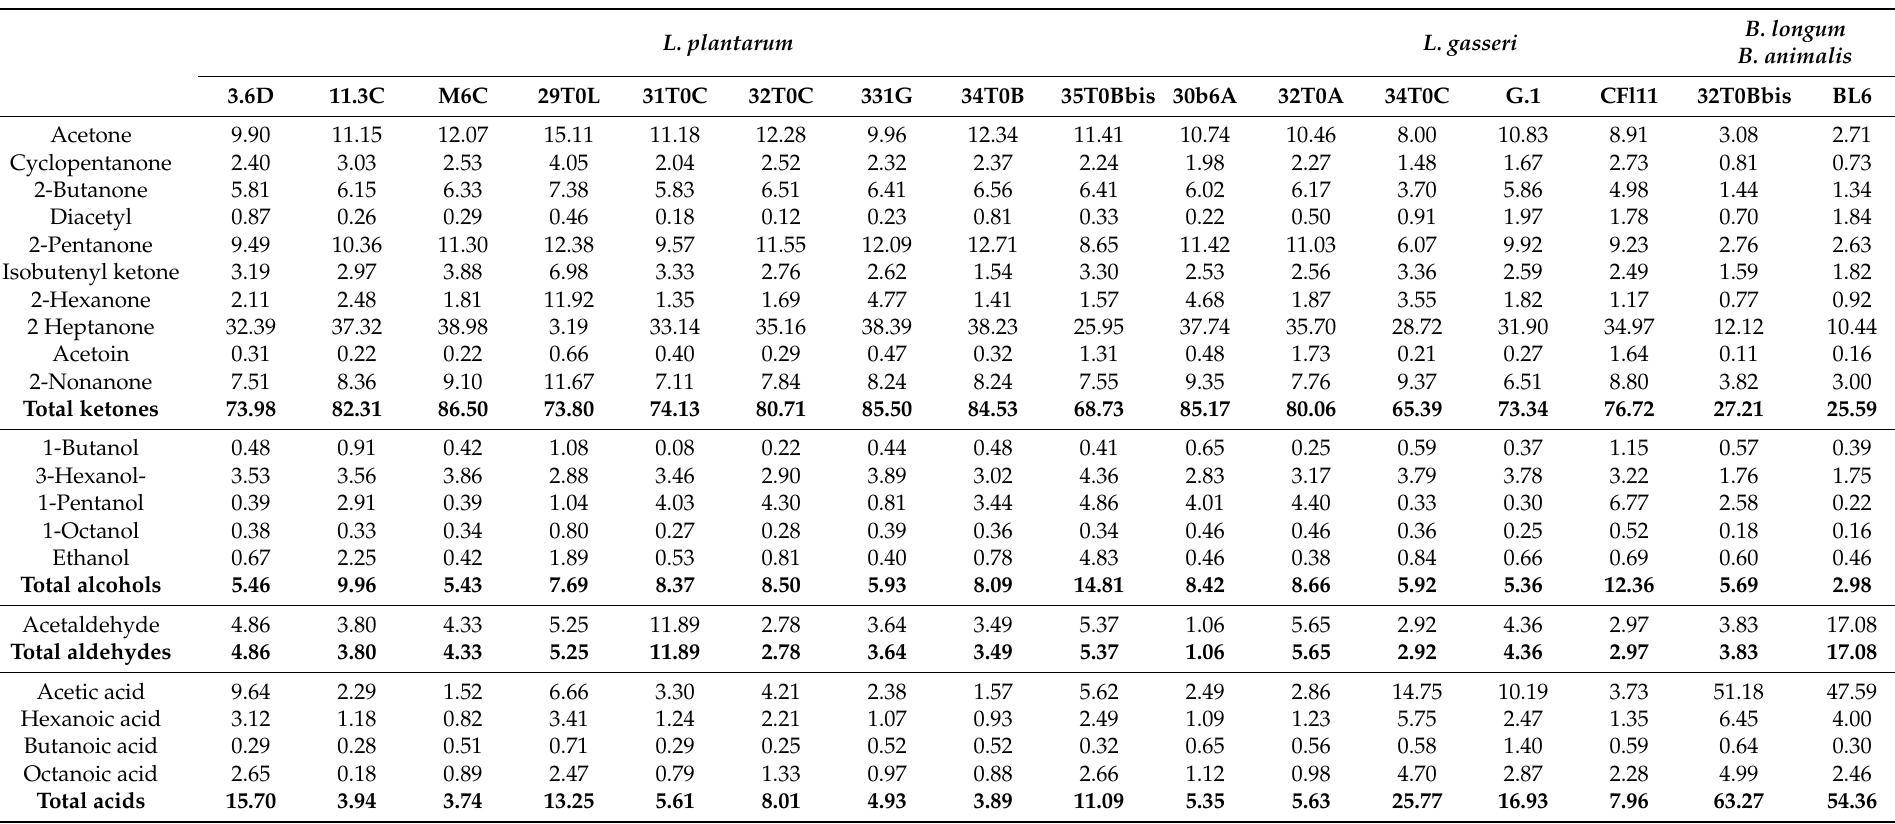
Table 9. Volatile compounds (reported as relative percentages) of pasteurized whole milk samples, inoculated with lactobacilli/bifidobacteria isolated from human breast milk and collected after 48 h of incubation at 37 ◦ C; detected by GC-MS-SPME